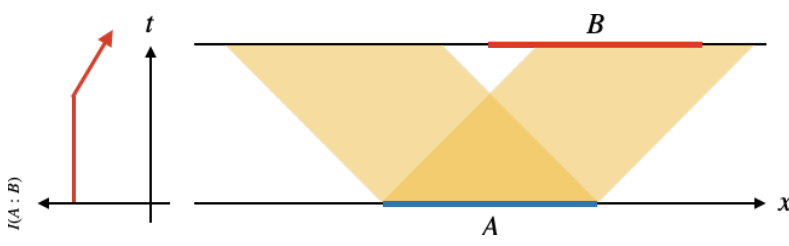
Figure 4 . A cartoon of the quasi-particle picture for operator entanglement. At t = 0, the quasi-particles (yellow) are emitted from region A and move at the speed of light. The quasi- particle picture for operator entanglement dictates that the operator mutual information between input region A and output region B is the number of quasi-particles located within region B that originated from A (the overlap section between region B and the yellow area). On the left, we display a sketch of the operator mutual information between A and B for the partially overlapping con(cid:12)guration: after a certain time I (2) ( A; B ) starts to decrease due to the quasi-particles leaving region B